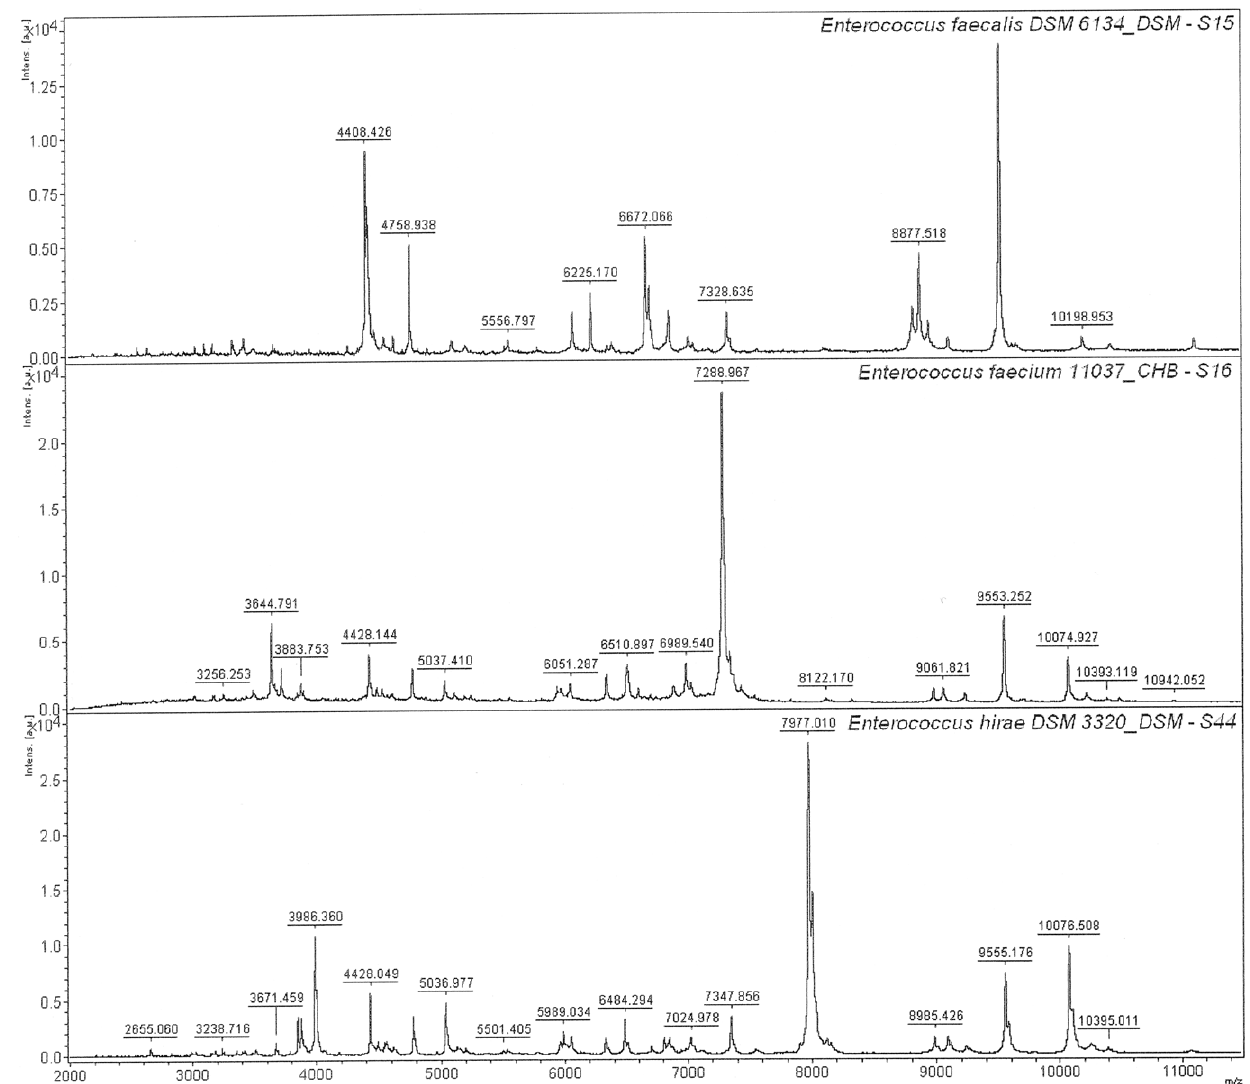
Figure 4. MALDI-TOF mass spectra for Enterococcus isolates. 16S rRNA gene analysis indicated that isolates S15 and S44 are the same species ( E. hirae ). However the protein fingerprints were not quite the same. The identification result using Biotyper software is shown at the top-right corner followed by the strain designations.